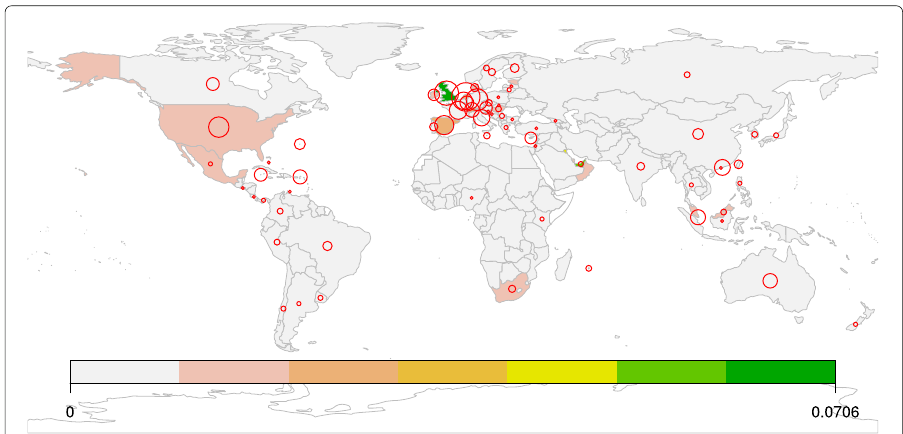
Fig. 12 “Holding & conduit” companies and Treaty shopping. The size of the circles indicates the number of “holding and conduit” companies and the depth of the color indicates the possibility to be used for treaty shopping by the